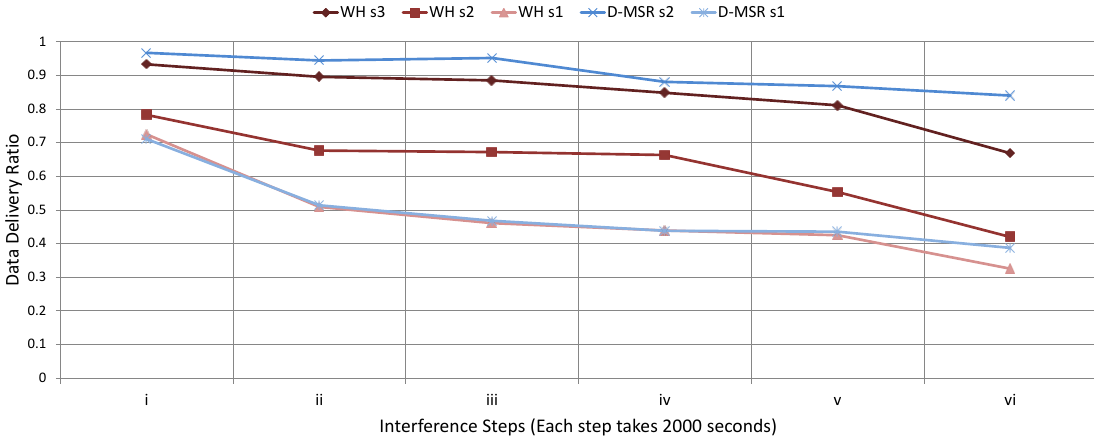
Figure 27. Data delivery ratio differences in five scenarios.